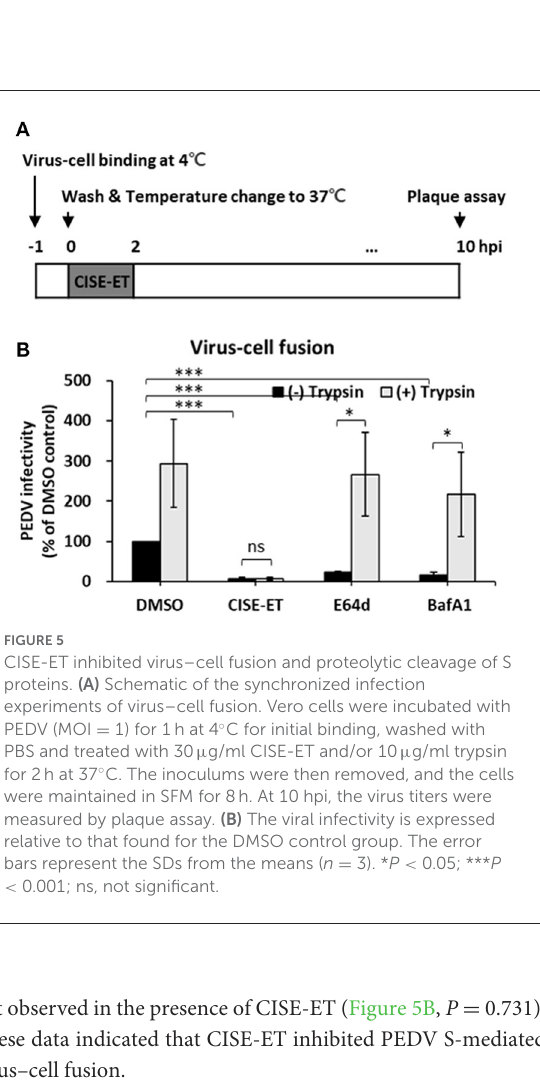
Figure 6C) pseudovirus transduction. VSV entry was not affected by either CISE or CISE-ET (Figure 6D). These results indicated that CISE also exhibited antiviral activity against select viruses in the Coronaviridae